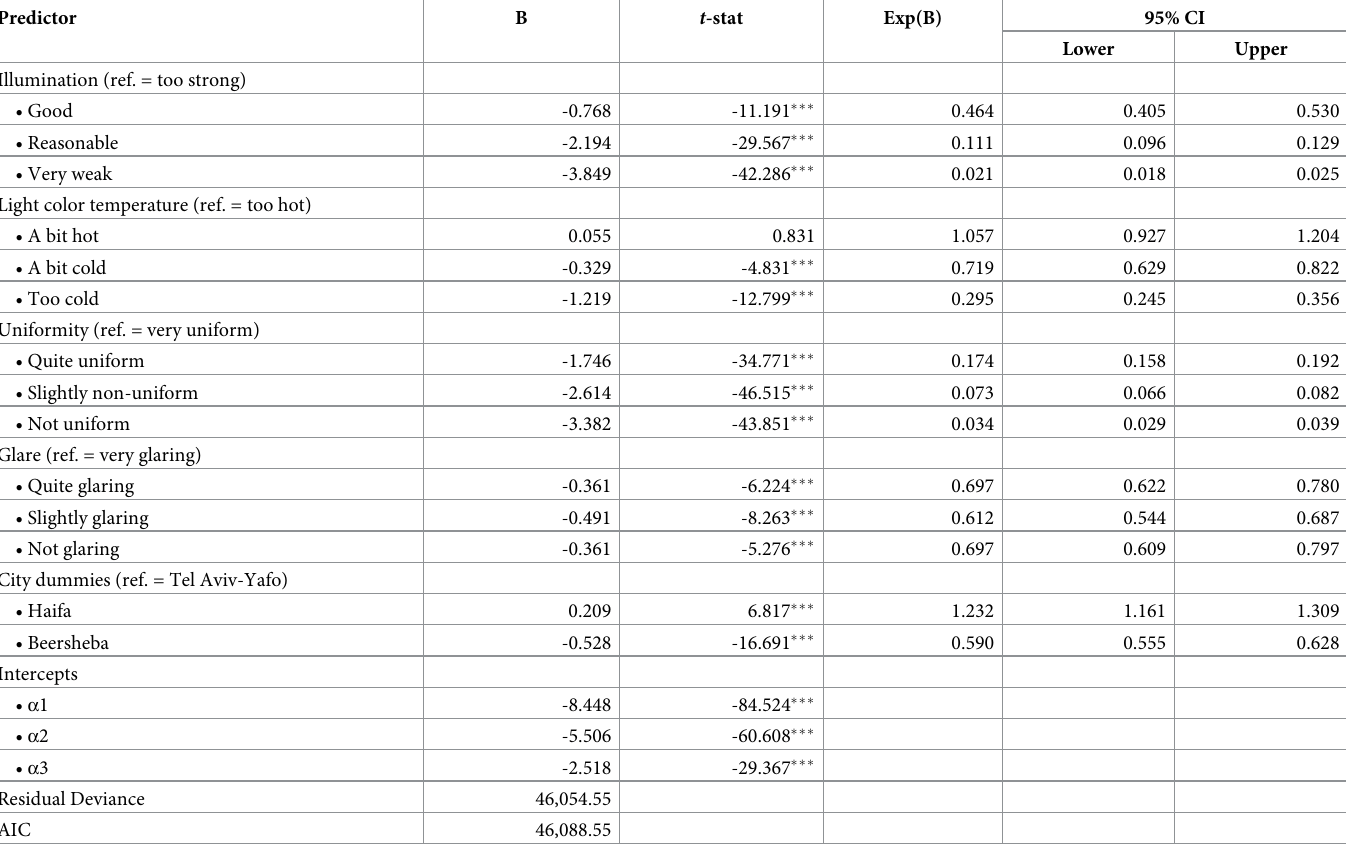
Table 4. Factors affecting FoS in the neighborhoods surveyed (method: Multiple ordinary regression; dependent variable–FoS on a 4-point scale from 0 (very unsafe) to 3 (very safe); Model 2: City dummies added).